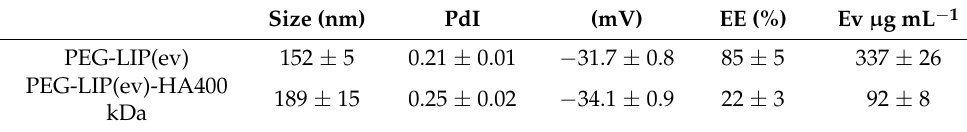
Table 1. Characteristics of PEG-LIP and PEG-LIP-HA400kDa loaded with